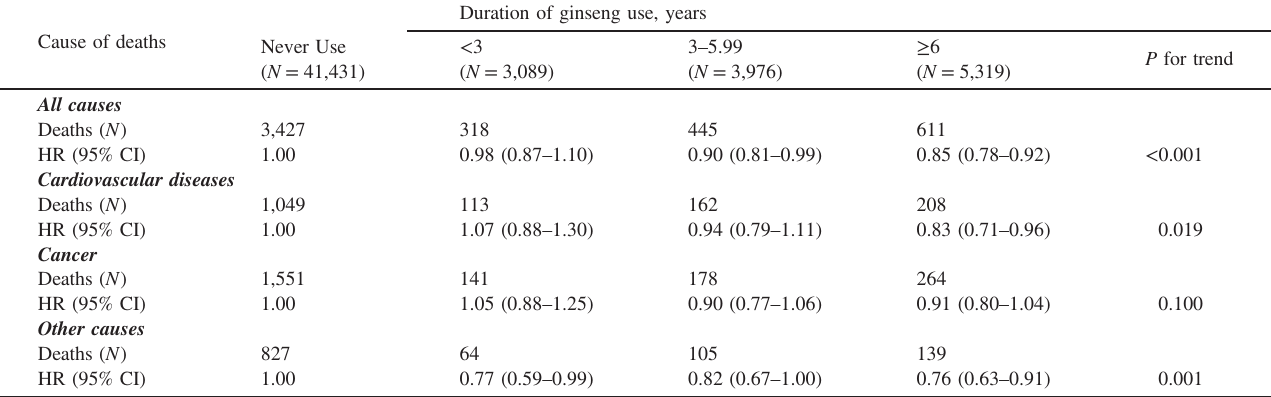
Table 3. HR a and 95% CI of mortality associated with duration of consuming either American or White ginseng among individuals who consumed ginseng for perceived general bene fi t for enhancement of health, Shanghai Women ’ s Health